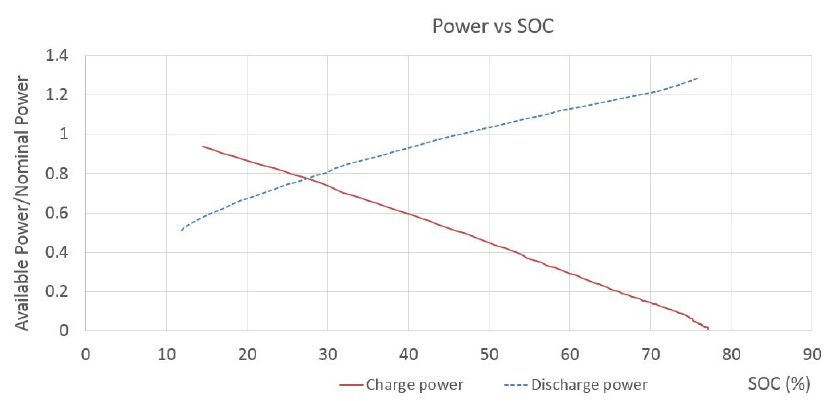
Figure 10. Variation of available discharge (blue) and charge (red) power, relative to the nominal power with the battery